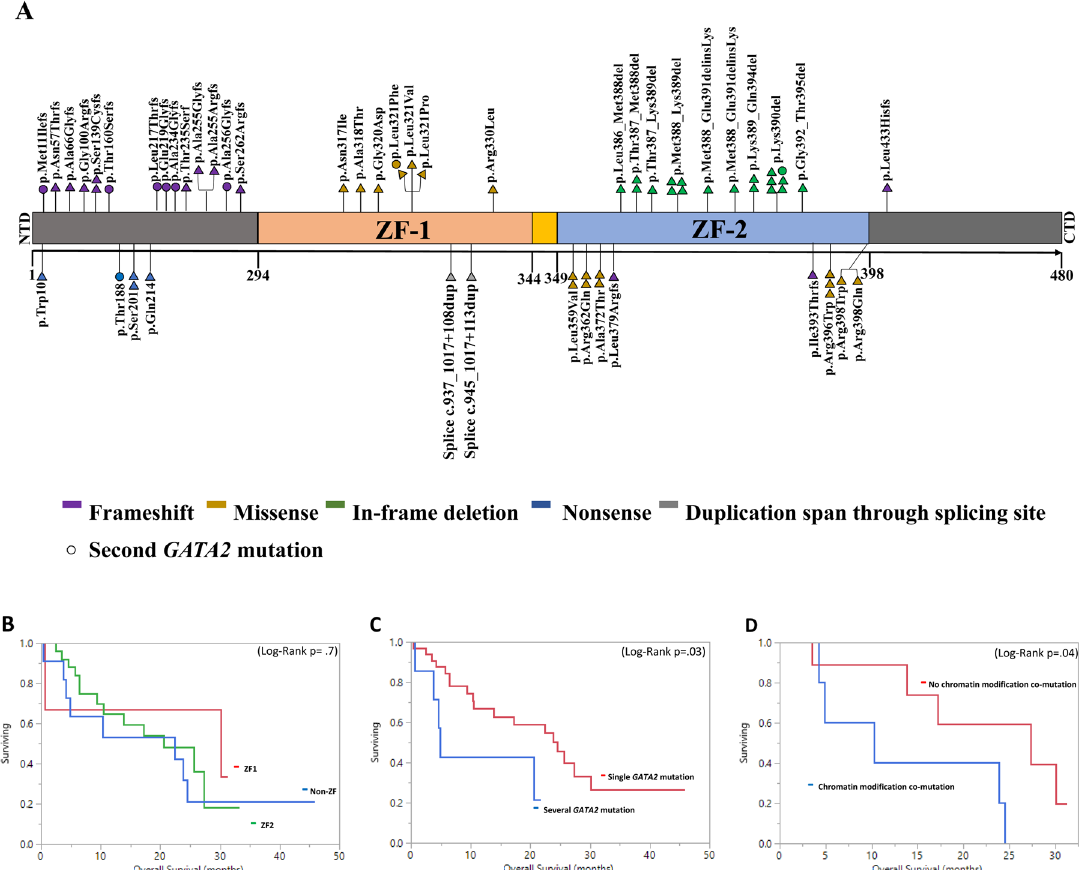
Fig. 1 GATA2 gen mutations distribution and survival outcome in myeloid neoplasms. A Representation of GATA2 variants detected, positioned on the GATA2 protein, and its functional domains. NTD N-terminal domain, ZF zinc fi nger domain, CTD C-terminal domain. Kaplan – Meier survival curves for OS B Strati fi ed by GATA2 mutation location in 40 chronic myeloid neoplasm patients. There was no difference in median OS between GATA2 -ZF1, ZF2, and non-ZF mutations (30 vs. 20.6 vs. 22.4 months, p = 0.7). C Strati fi ed by the number of GATA2 mutations in 40 chronic myeloid neoplasm patients. D Strati fi ed by chromatin modi fi cation co-mutation status in 15 MDS